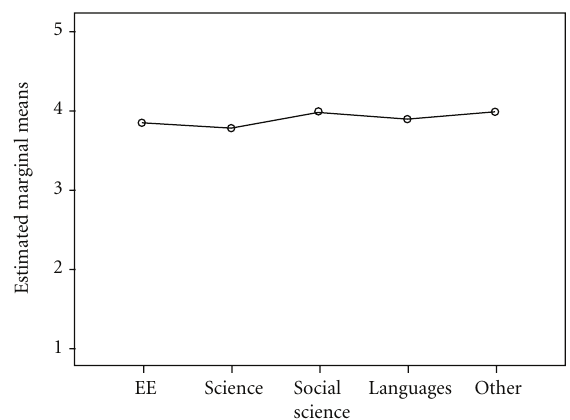
Figure 2: 5 Preventing social bias. Estimated Marginal means of 5 preventing social